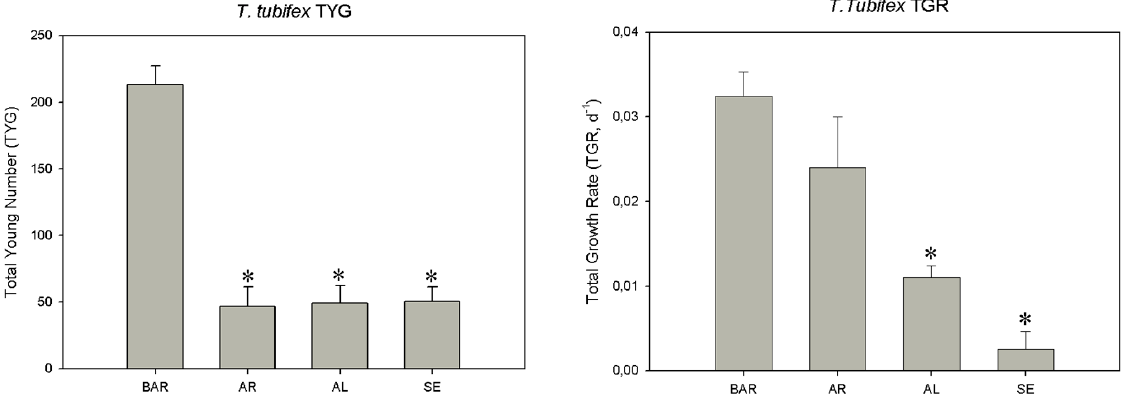
Figure 3. Mean and SD of toxicity endpoints of the T. tubifex bioassay: TGR (d − 1 ), TYG, and mortality (%) at each station. Asterisk (*) indicates significant differences ( p < 0.05) between samples and the control (BAR).